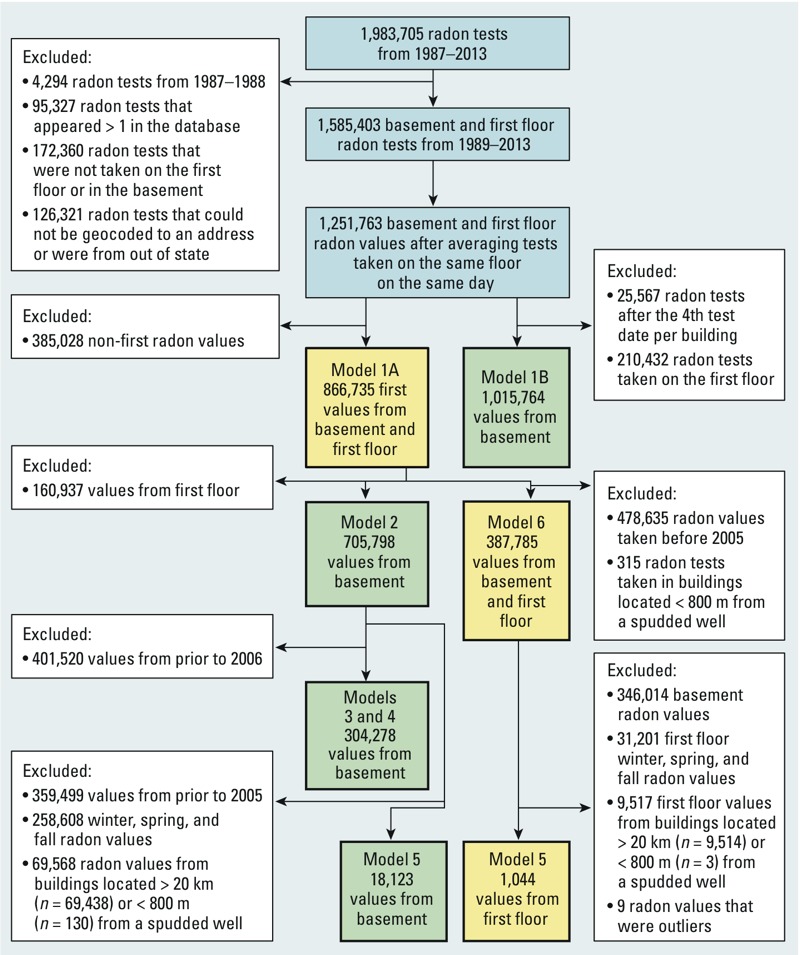
Flow diagram of radon tests included in six primary models.